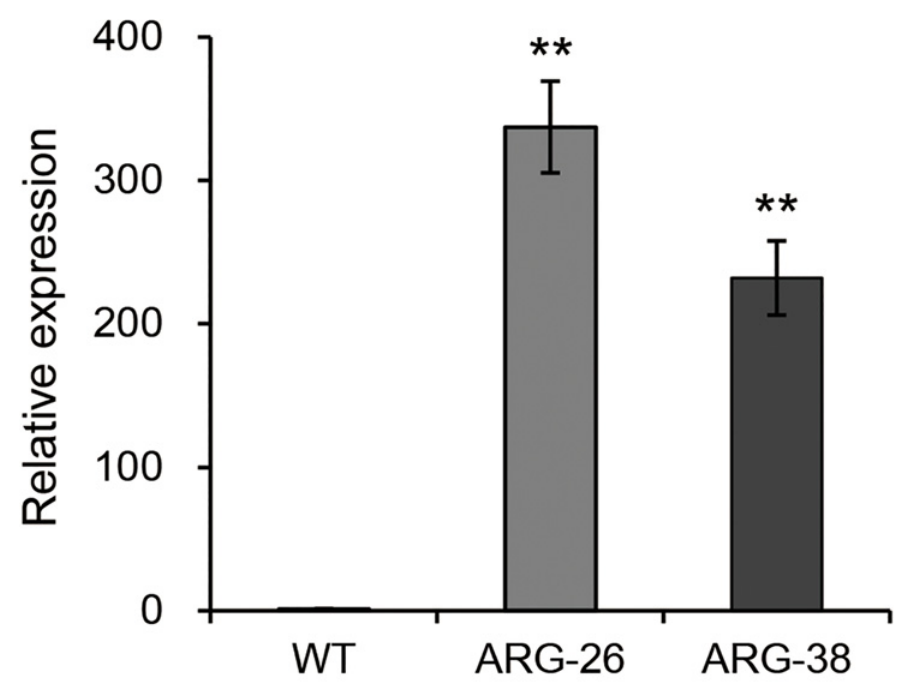
Fig 4. Quantitative PCR analysis of OsArg expression in the leaves of ARG-26 and ARG-38 transgenic cotton. The OsARG gene was detected in ARG-26 and ARG-38 leaves but not in non-transgenic control leaves. ‘ WT ’ refers to non-transgenic control plants of wild type cotton. ** : P <